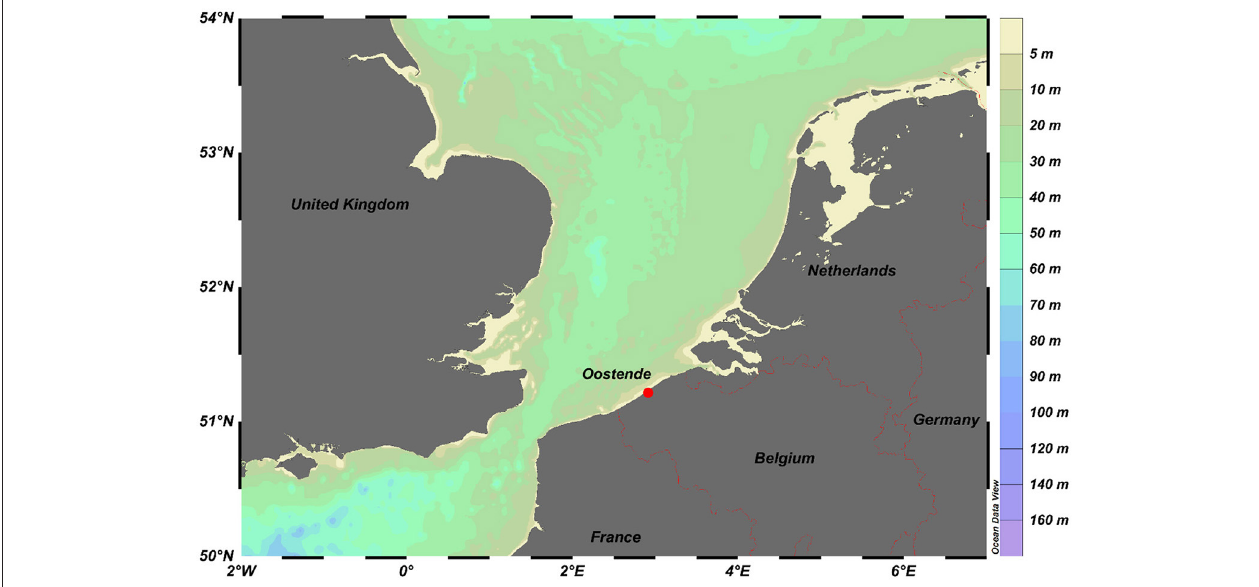
FIGURE 2 | Sampling station Oostende at the Belgium coast (Schlitzer, Reiner; Ocean Data View, https://odv.awi.de,